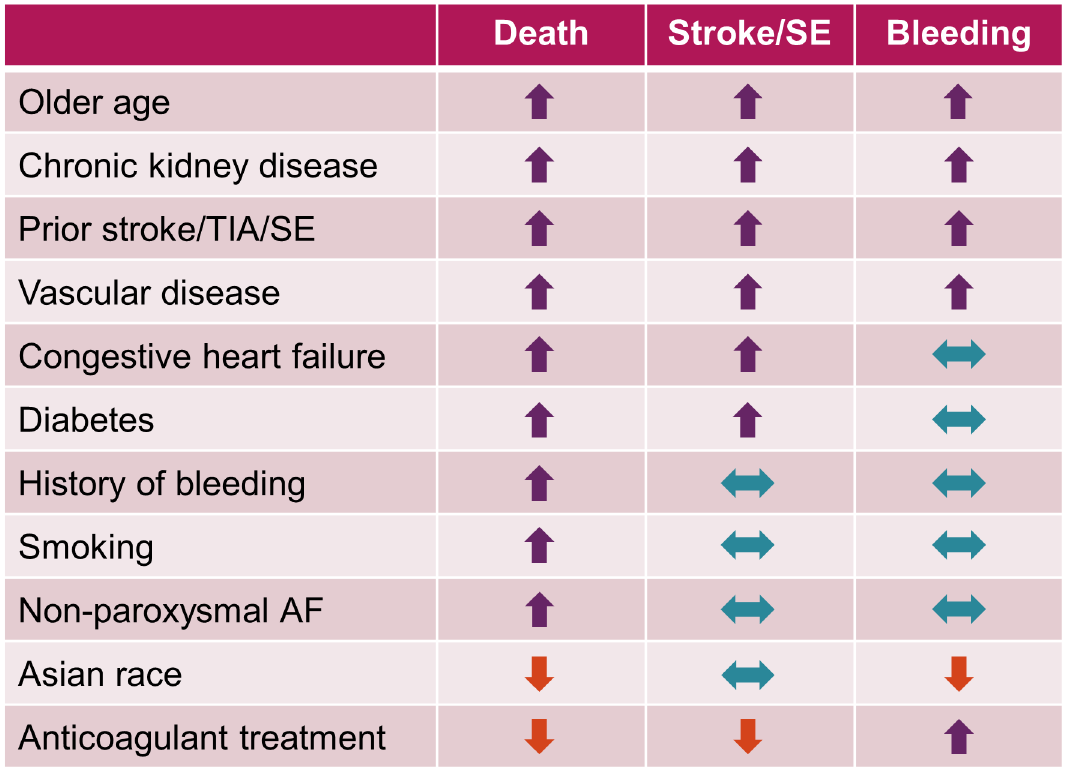
Fig 2. Relationships between variables and clinical outcomes during 2-year follow-up. Key to symbols used: upwards arrow indicates increased risk, downwards arrow indicates reduced risk, double-headed arrow indicates no change in risk. AF, atrial fibrillation; SE, systemic embolism; TIA, transient ischaemic attack.